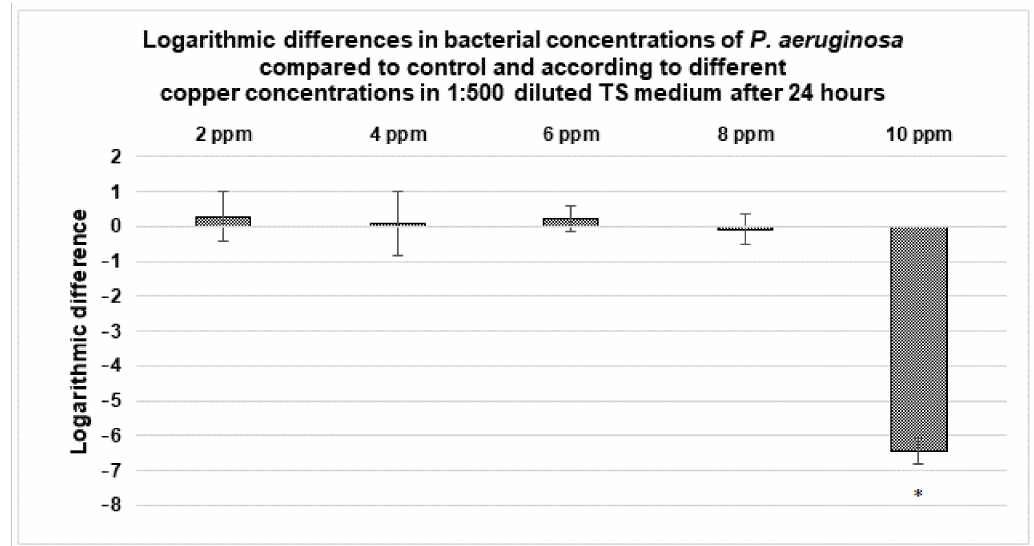
Figure 6. Variation in the bacterial concentration of P. aeruginosa with respect to different copper concentrations in 1:500 diluted TS medium after 24 h. Results statistically different compared to the control (with p < 0.05) are indicated by “*”.